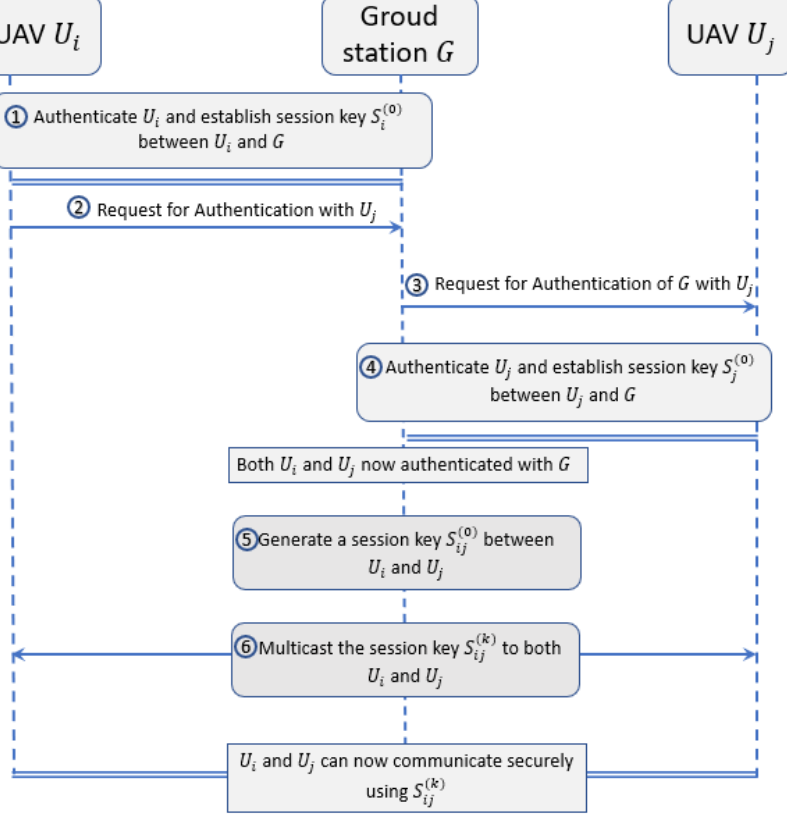
Figure 3. Sequence of messages exchanged during inter-UAV authentication. Double lines between devices indicate that the two devices are mutually authenticated and can use a secret key for future secure